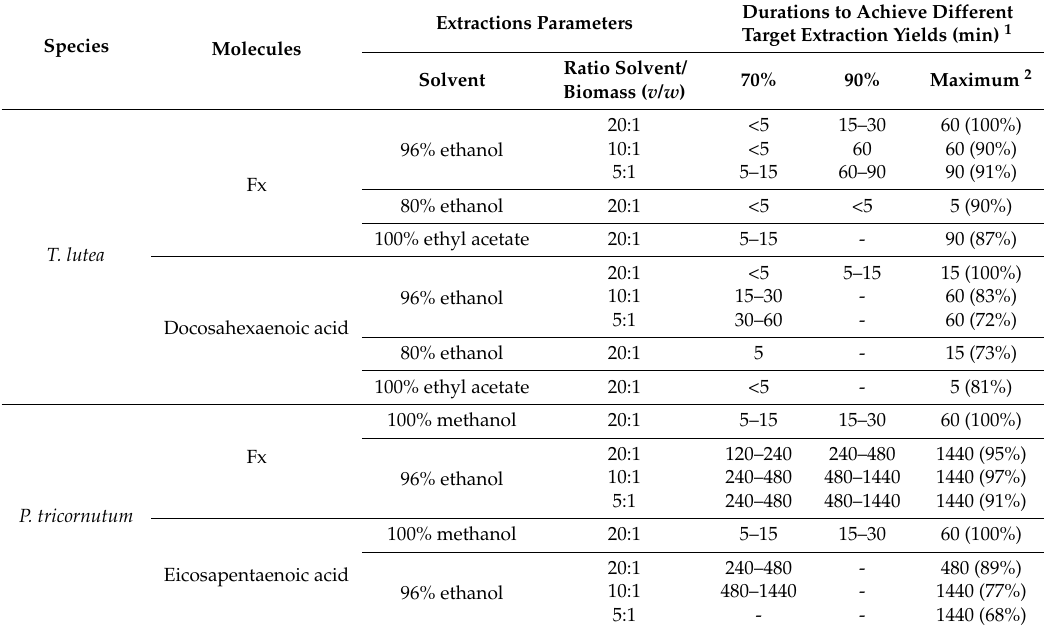
Table 2. Influence of solvent nature and the solvent/biomass ratio on the kinetics and yield of fucoxanthin (Fx) and long chain polyunsaturated fatty acids (PUFAs) extraction from freeze-dried T. lutea and P. tricornutum biomasses. Kinetics were followed during 90 min for T. lutea and 1440 min for P. tricornutum . Hyphens indicate that the target yield was not achieved. Where two values are indicated, the yield was reached between these two durations.